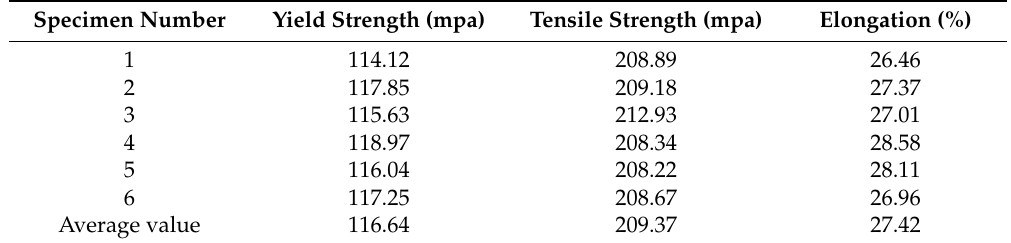
Figure 11. The stress-strain curves of 5052-O aluminum alloy at 0°, 45° and 90° to the rolling direction. Table 5. Mechanical properties of the 5052-O aluminum alloy sheet.